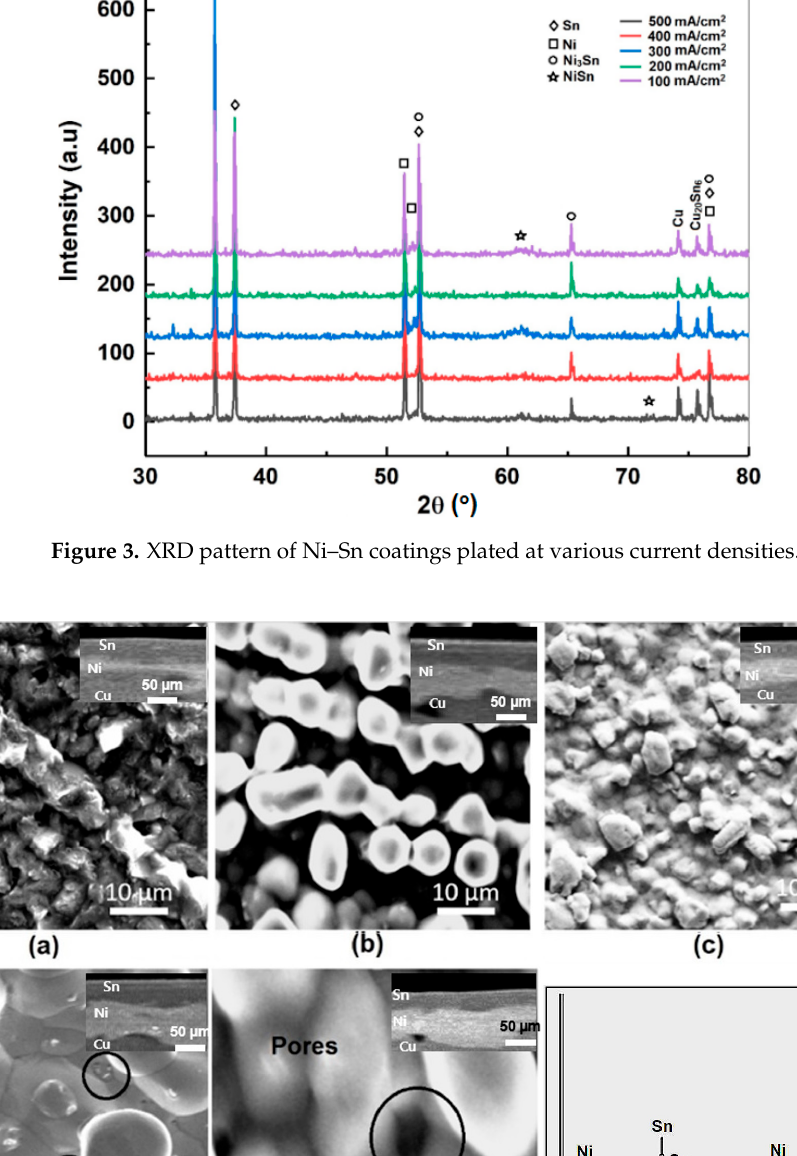
Table 3. Compositional analysis of Sn-plated Ni/Cu coatings.